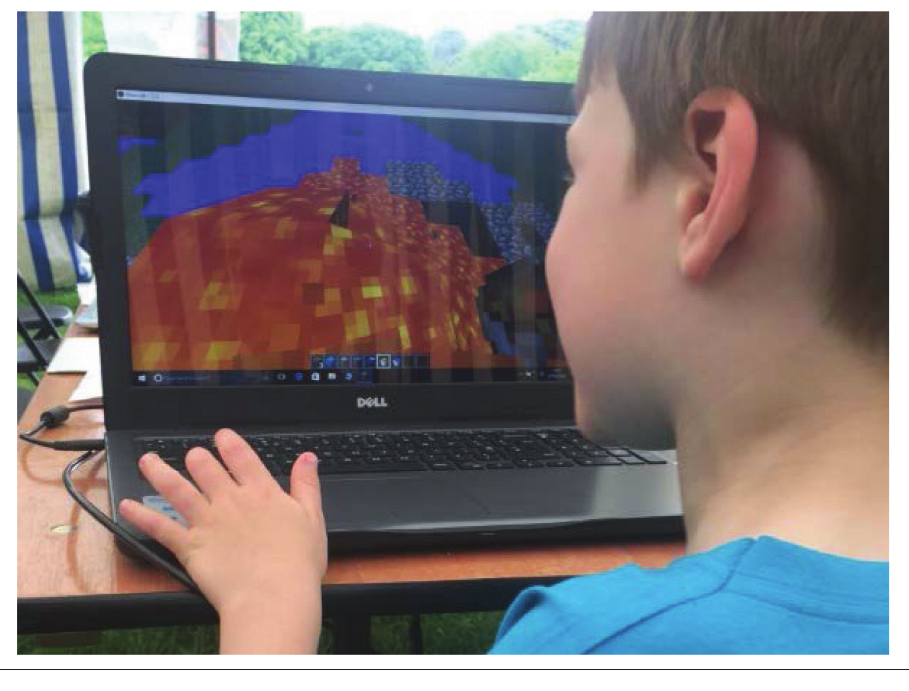
Figure 2: A 5-year-old child explores lava and water interactions in Minecraft at a Science Hunters public event